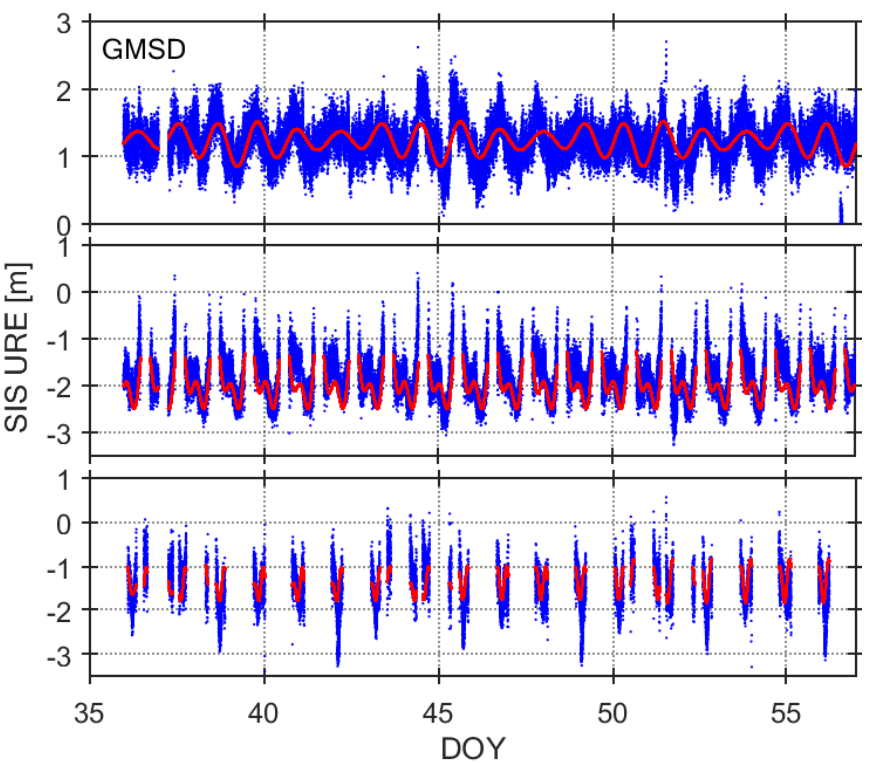
Figure 6. Examples of SIS-URE time series of Station GMSD, C04 ( top ), C09 ( middle ) and C14 ( bottom ), DOY 036–056, 2017, SIS UREs ( blue ) and Fourier models ( red ) on B1 band.